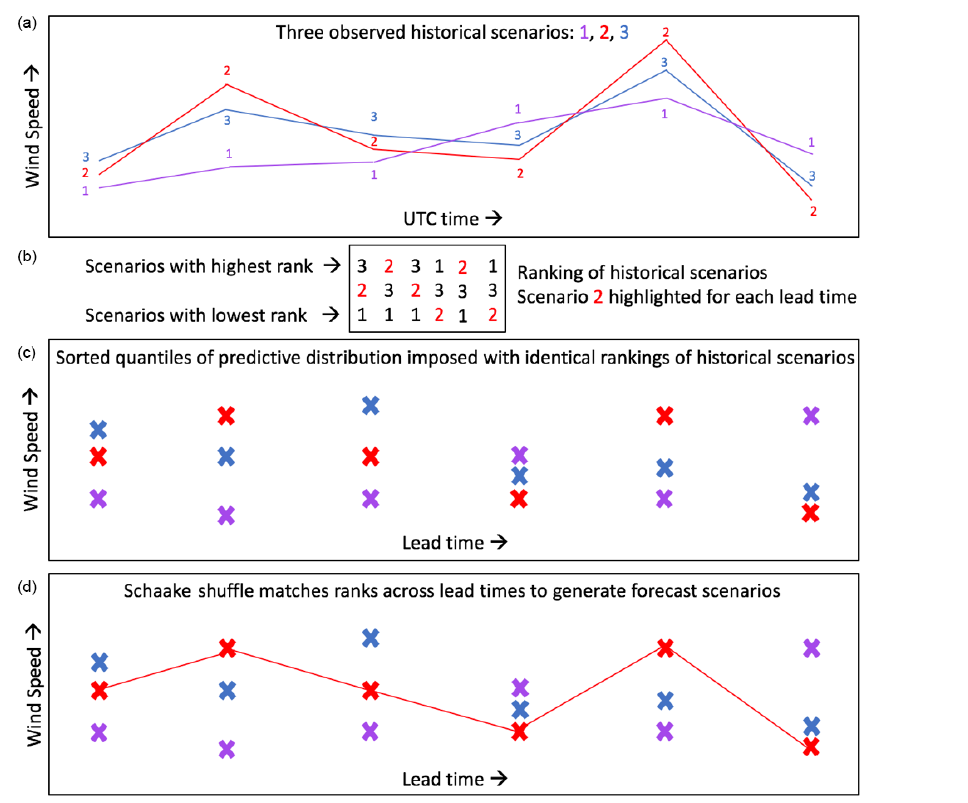
Figure 6. Illustration of how the Schaake shuffle method generates three wind speed forecast scenarios for a given date. For a given forecast date, three observed historical scenarios of wind speed are selected from the historical record (a) . The historical scenarios are ranked (b) and then the same ranking is imposed onto the sorted forecast quantiles (c) . The forecast quantiles are connected across forecast lead time according to their corresponding rank (d) . In panel (b) , we emphasize the ranking of the second historical scenario to show how the ranking of a historical event manifests itself in the shape of a forecast scenario in (d)